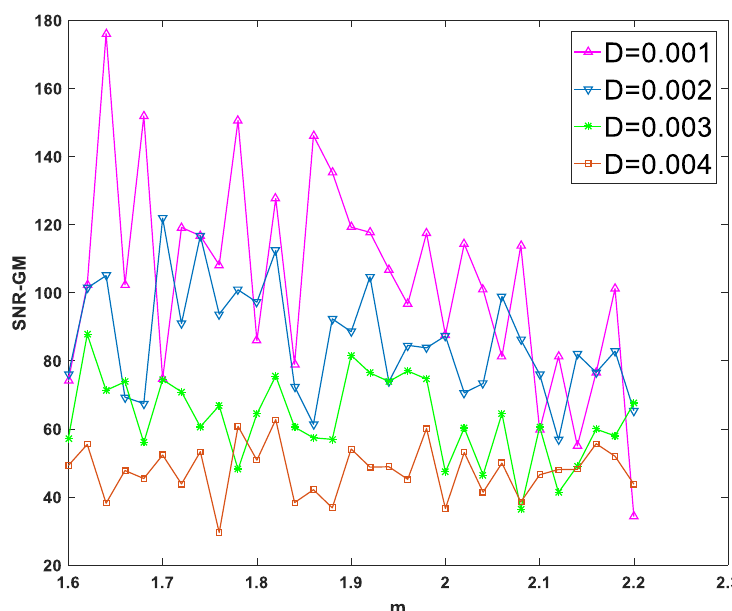
Figure 5. SNR-GM varies with m for different values of D ( p = 0.5, q = 1.2).